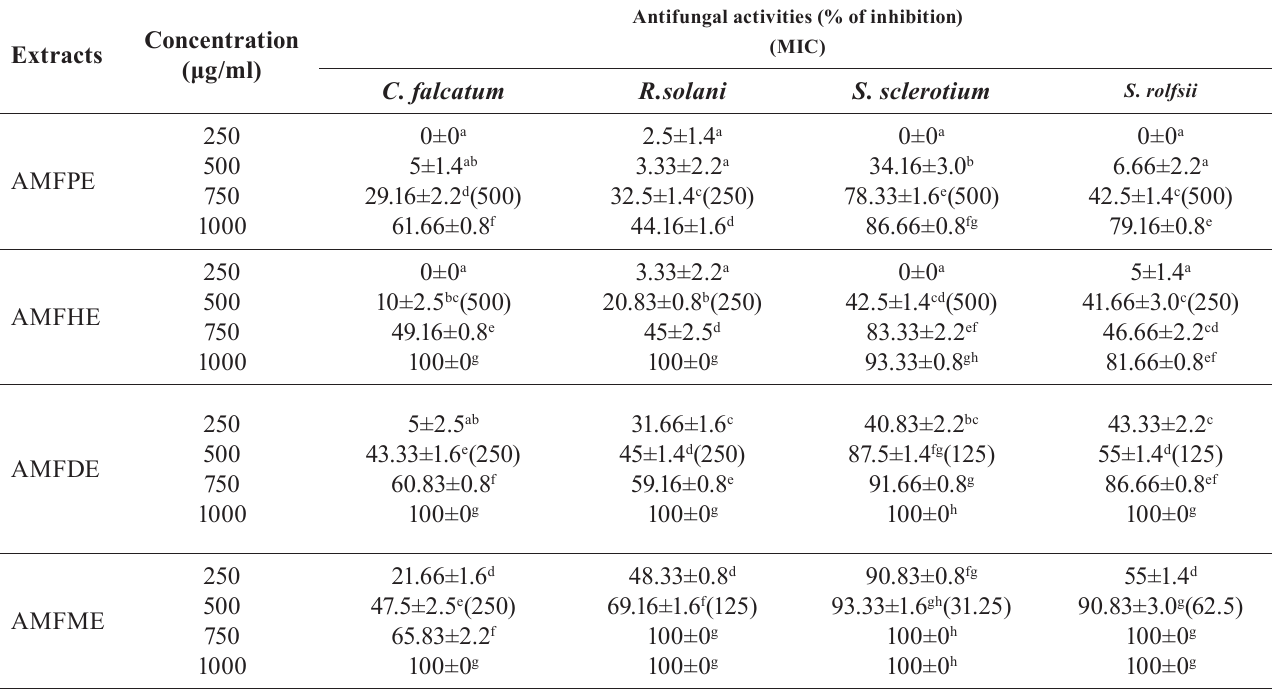
TABLE V - A ntifungal activity with MIC values of AMFEO and different extracts of A. malaccensis